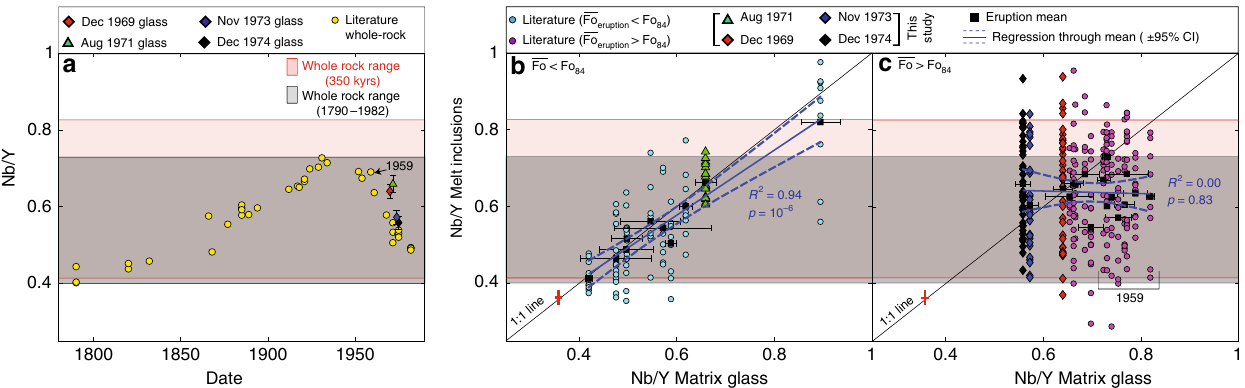
Fig. 2 Trace elements in melt inclusions hosted by primitive olivines record melt compositional variations over centuries to millennia. a Whole-rock data from summit eruptions displays large temporal variations in Nb/Y (refs. 35,36 ). Matrix glasses from the four eruptions analysed in this study follow similar trends, although the 1971 intracaldera eruption lags behind the May 1969 ERZ eruption (error bars show ±1 σ for glass measurements). The grey box shows the range of Nb/Y ratios in whole-rock compositions since 1790 (ref. 36 ), and the pink box shows the range of Nb/Y ratios in whole-rock compositions over the last 350 kyrs (ref. 44 ). b , c Nb/Y ratios of melt inclusions versus co-erupted matrix glasses (±1 σ glass analyses). Regression lines were calculated for the mean glass and melt inclusion composition of each eruption (95% con fi dence intervals on the regression are shown with dashed lines). Eruptions with mean forsterite contents <Fo 84 display a strong correlation between the mean Nb/Y ratio of melt inclusions and matrix glasses ( b ). While the 1961 summit eruption (glass Nb/Y ~0.89) certainly strengthens the observed correlation, the regression is still very good if this eruption is excluded ( R 2 = 0.84, p = 10 − 4 ). In contrast, there is no correlation between the mean Nb/Y ratios of melt inclusions and matrix glasses from eruptions with mean forsterite contents >Fo 84 ( c ). In particular, almost all melt inclusions from various episodes of the 1959 K ī lauea Iki eruption have signi fi cantly lower Nb/Y ratios than the composition of co-erupted matrix glasses. Nb/Y is shown for consistency with previous studies (refs. 1,27,36 ), and because this ratio shows the largest percent variation in historic lavas (see Supplementary Table 6). Additionally, this ratio is not sensitive to the fractionation of olivine and chromite, or post-entrapment crystallisation (see Supplementary Figs. 5 and 6). The red cross on b , c shows the precision for repeated analysis of BCR-2 (±1 σ ) in melt inclusions and